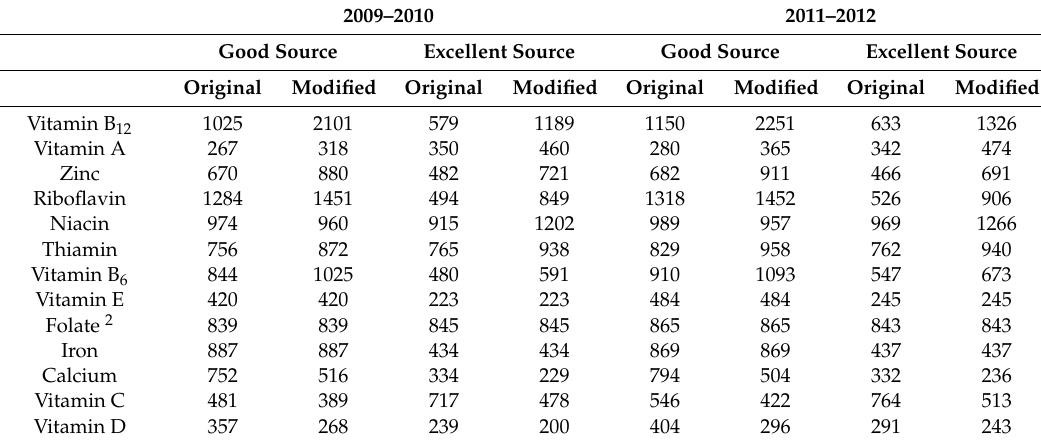
Table 3. Number of Foods with Good or Excellent Source Nutrient Content Claims in the Original Food Database (Original FD), and the Predicted Number in the Modified Food Database (Modified FD), based on the NHANES 2009–2010 and 2011–2012 1